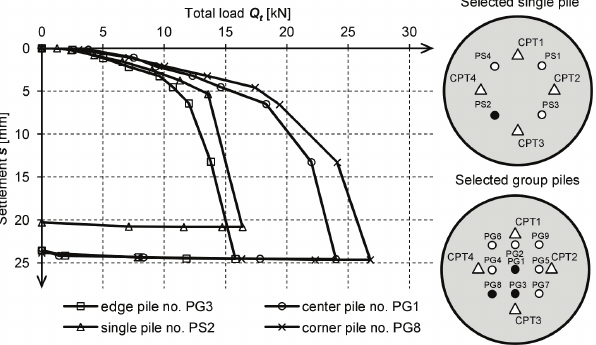
Fig. 7. Load-settlement characteristics of selected SDP